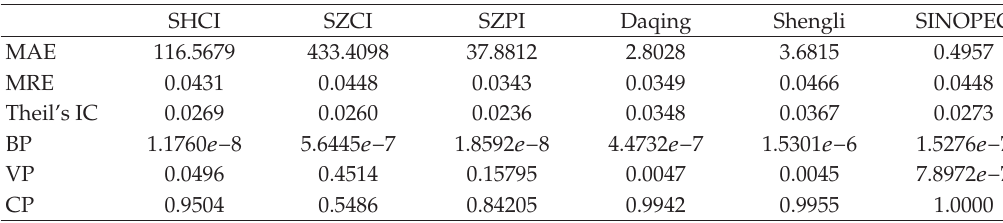
Table 2: Evaluation of the